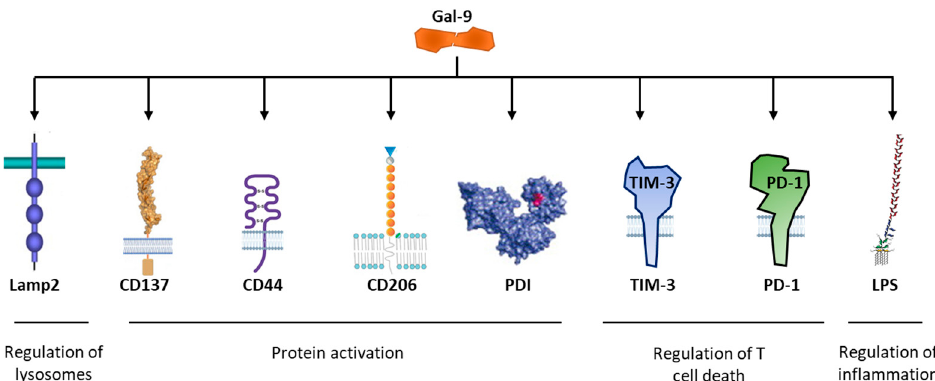
Figure 6. Gal-9 interacting partners: C137 (also known as 4-1BB) belonging to the TNF receptor superfamily; the CD44 adhesion molecule; the macrophage M2 biomarker CD206; protein disulfide isomerase (PDI) via binding to its O -glycans; the lysosomal associated membrane protein 2 (Lamp2); bacterial lipopolysaccharide (LPS) and the checkpoints TIM-3 and PD-1. The list is non-exhaustive. As a glycan-binding immunomodulatory factor, Gal-9 can have numerous glycosylated protein partners.